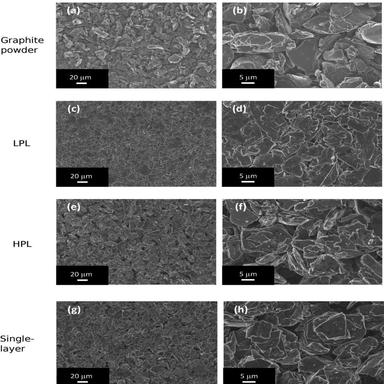
FE-SEM images at X1000 (left column) and X5000 (right column) magnification of (a, b) the graphite powder, (c, d) the LPL and (e, f) the HPL of the bi-layered coating, and (g, h) of the single-layered coating.